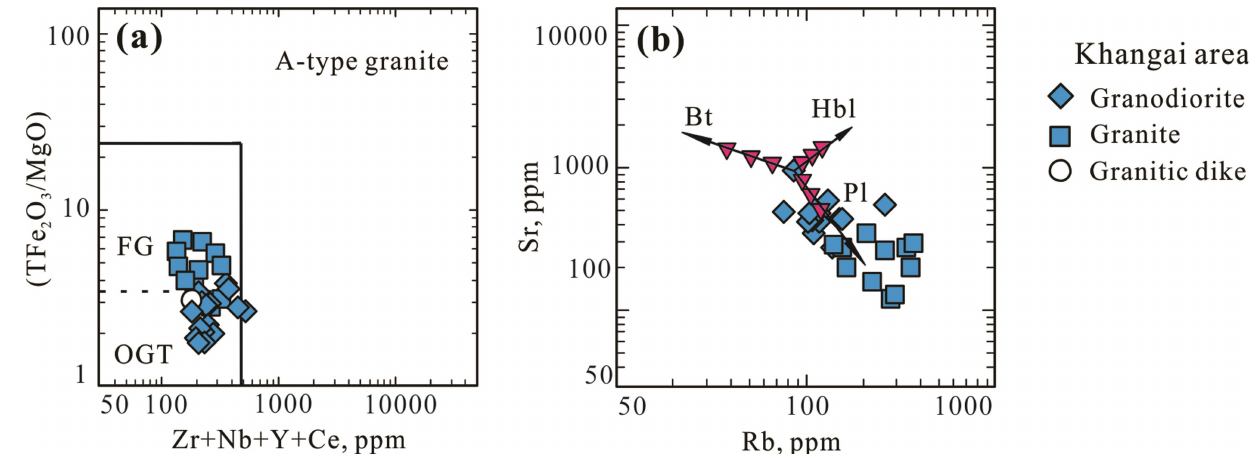
Fig. 11. Diagrams showing granitic rocks from the Khangai area plotted on tectonic discrimination diagrams. (a) TFe O /MgO vs. (Zr + Nb + Y + Ce) after Whalen et al. (1987) with abbreviations as in Fig. 9. (b) 2 3 Rb vs. Sr diagram showing compositional vectors reflecting the fractionation of biotite (Bt), hornblende (Hbl), and plagioclase (Pl) within granitic systems. Each vector reflects 30% crystallization with pink triangles indicating 10% fractionation intervals. Partition coefficients used are from Arth (1976) and the initial composition is the same as sample